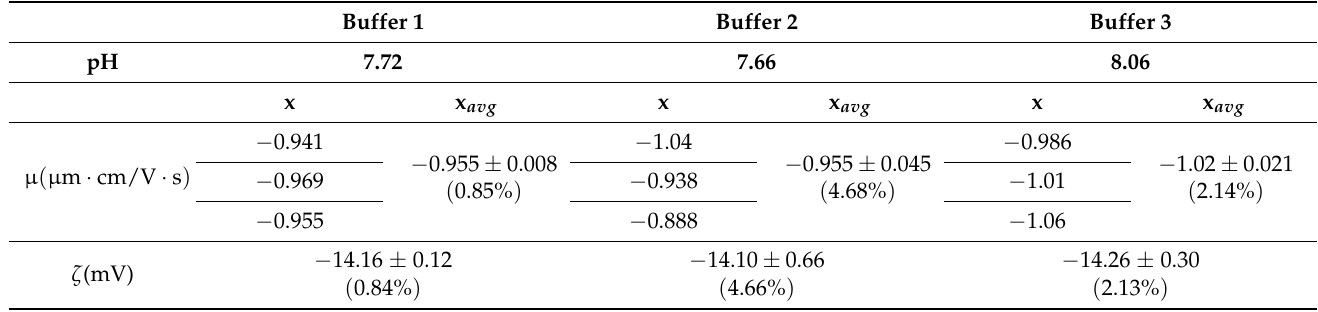
Table 5. Electrophoretic mobility ( µ ) values obtained from ELS experiments. For each buffer, we enlisted the three measured electrophoretic mobility values in the first column, while the mean value, the uncertainty (standard deviation of the mean value), and percentage error are provided in the second column. The zeta potential ( ζ ) parameter was evaluated using Oshima’s